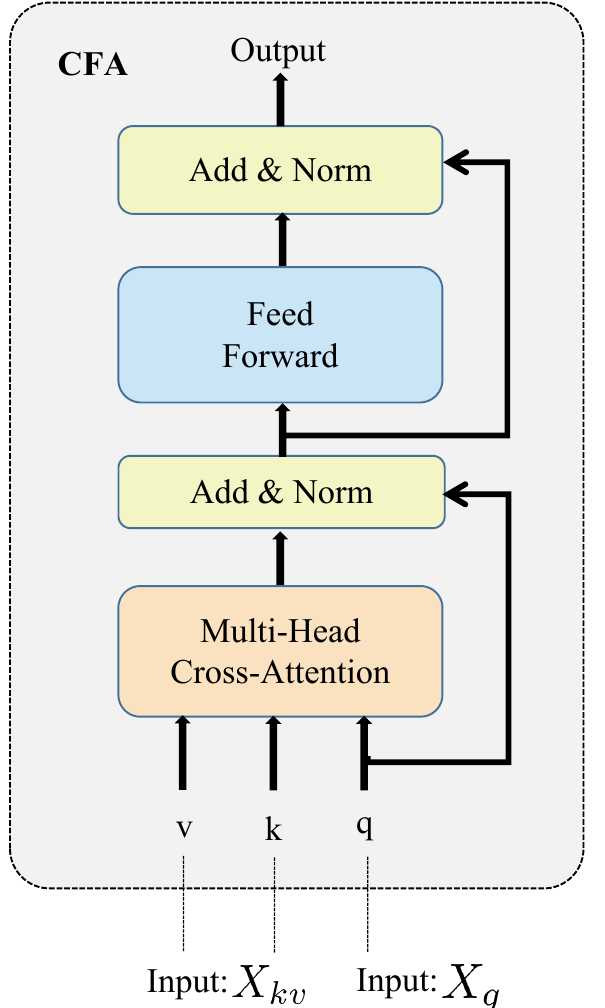
Figure 6. The structure of the CFA module. The input X q receives the feature from the branch, and the input X kv receive the feature from the other